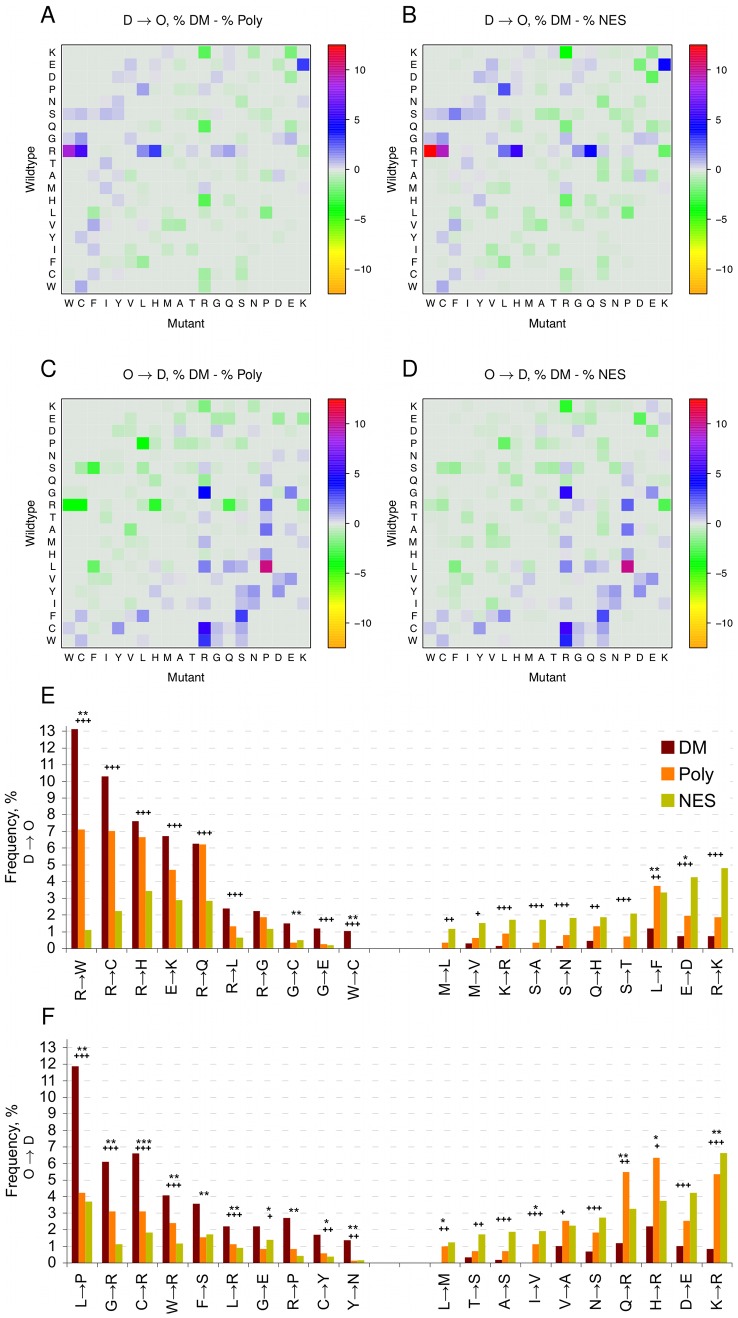
Enrichment and depletion of D→O (panels A, B, E) and O→D (panels C, D, F) mutations as % of disease mutations in comparison to % of polymorphisms (Poly; panels A, C) and % of neutral evolutionary substitutions (NES; panels B, D).In the heatplots (panels A, B, C, D) wild-type residues are on the Y-axes and the mutant residues on the X-axes. The residues are arranged according to the Vihinen flexibility scale [83]. In panels E and F, frequencies of top ten D→O (panel E) and O→D (panel F) mutations enriched and depleted in the DM dataset are shown. * signify Fisher's exact P-values of DM vs. Poly; + signify p-values of DM vs. NES. *** or +++ − P<0.001; ** or ++ − P between 0.001–0.01; * or + − P between 0.01–0.05.